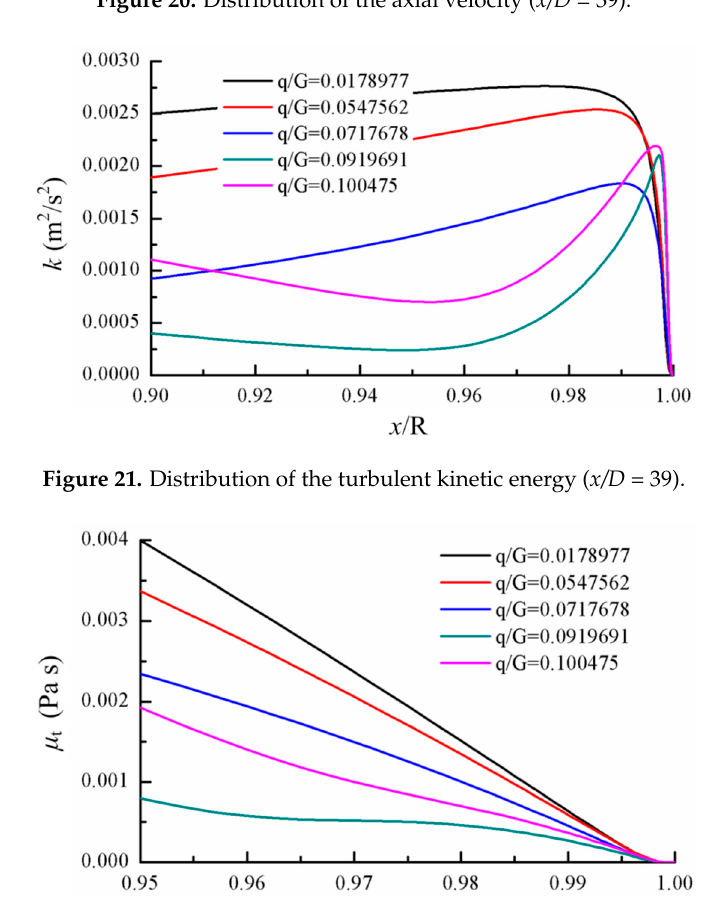
Figure 20. Distribution of the axial velocity ( x/D = 39). Energies 2017 , 10 , 1870